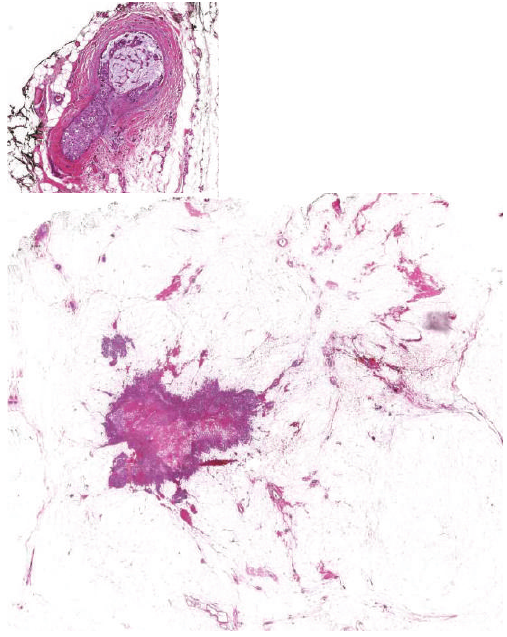
Figure 1: Quadrantectomy: a small focus of DCIS, immersed within the fatty tissue, is present in a surgical margin (inset).